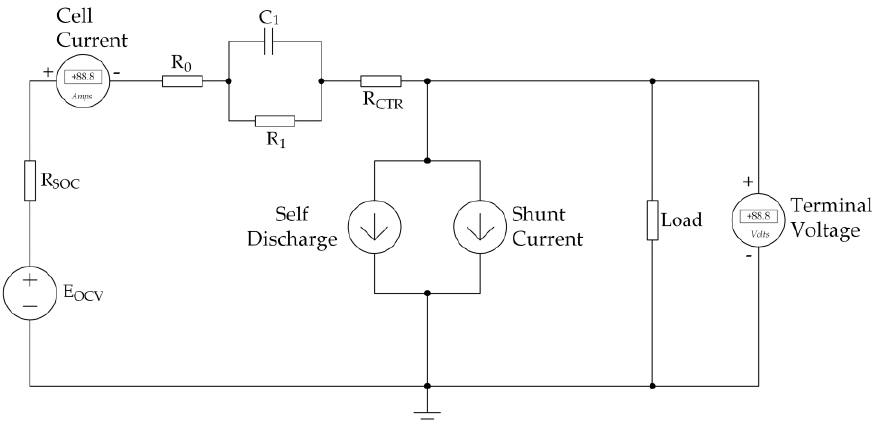
Figure 1. Novel comprehensive equivalent circuit model.